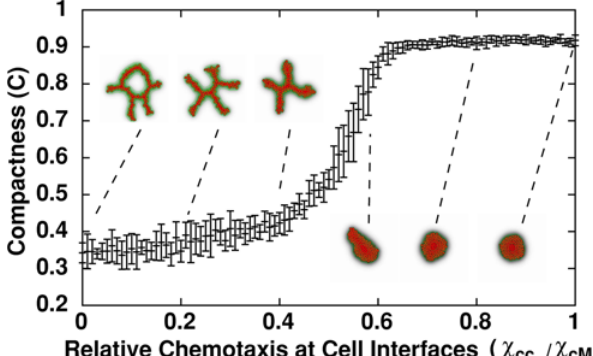
Figure 5. Compactness ( C = A cluster / A hull ) of 128-cell clusters after 10,000 MCS ( , 80 h) as a function of the relative chemotactic response at cell-cell vs. cell-ECM interfaces. Error bars show standard deviations over ten simulations.